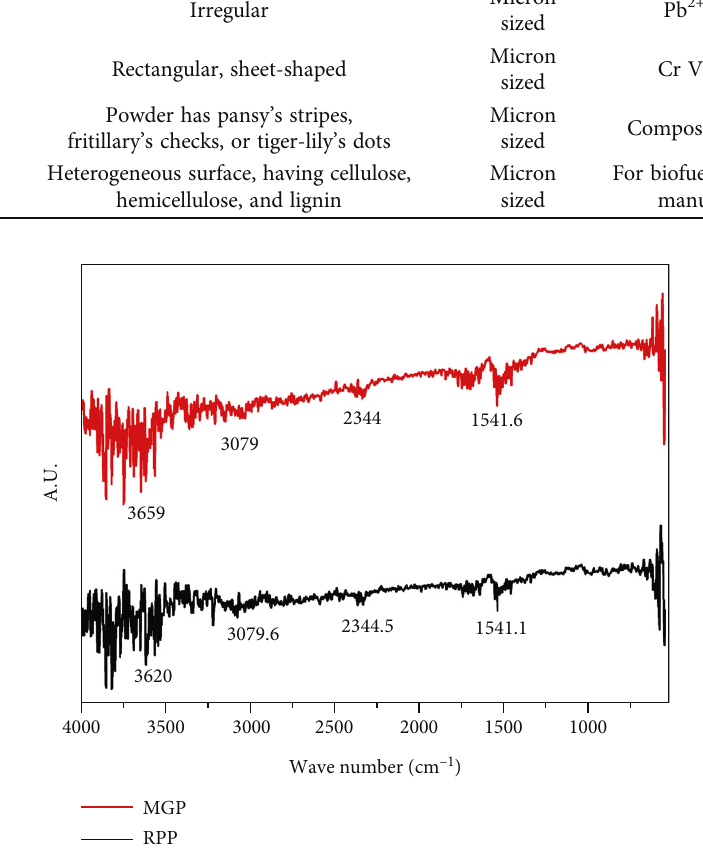
Figure 7: FT-IR spectrum of Rose Petal powder and Marigold fl owers. Table 2: FT-IR peak assignments of MGP and RPP along with previous work